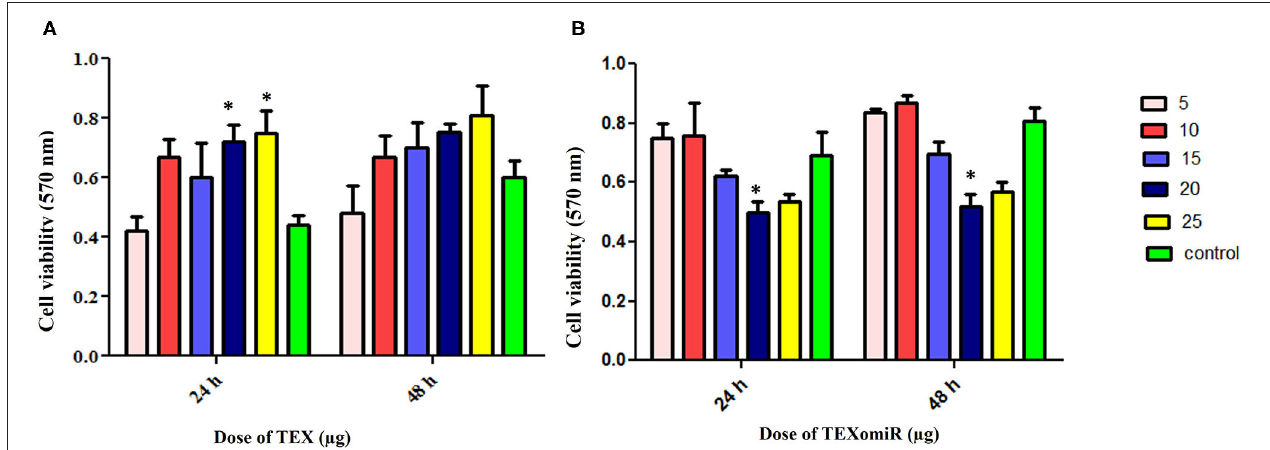
FIGURE 4 | Evaluation of the cytotoxicity effect of TEXomiR delivery on CT-26 cells. (A) Proliferation and cell viability were significantly increased by tumor exosome in a dose-dependent manner. (B) TEXomiR showed significant cytotoxicity at the dose of 20 and 25 µ g. The data are representative of three independent experiments and presented as mean ± SD. * P < 0.05 vs. untreated or control group.